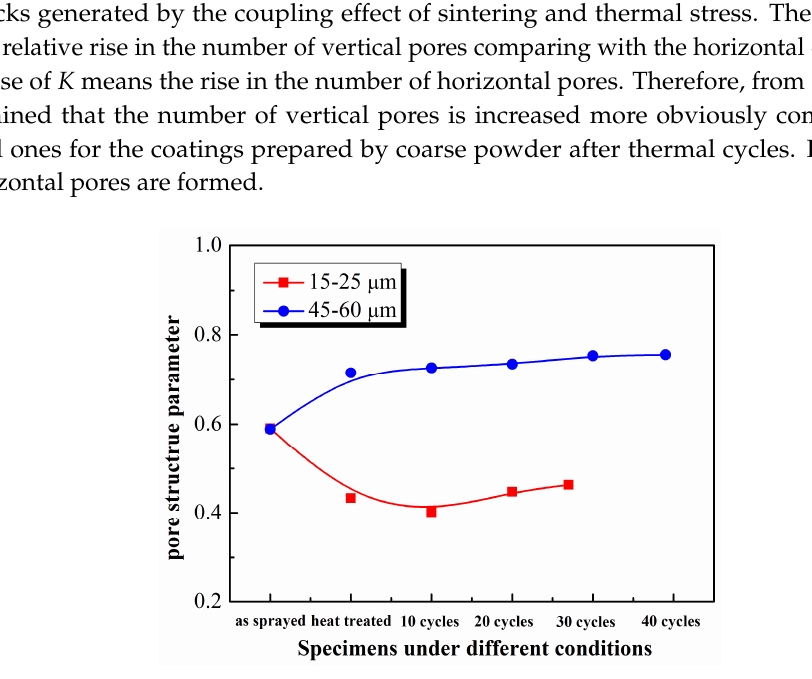
Figure 11. Variation of pore structure parameters K of coatings during thermal shocks.